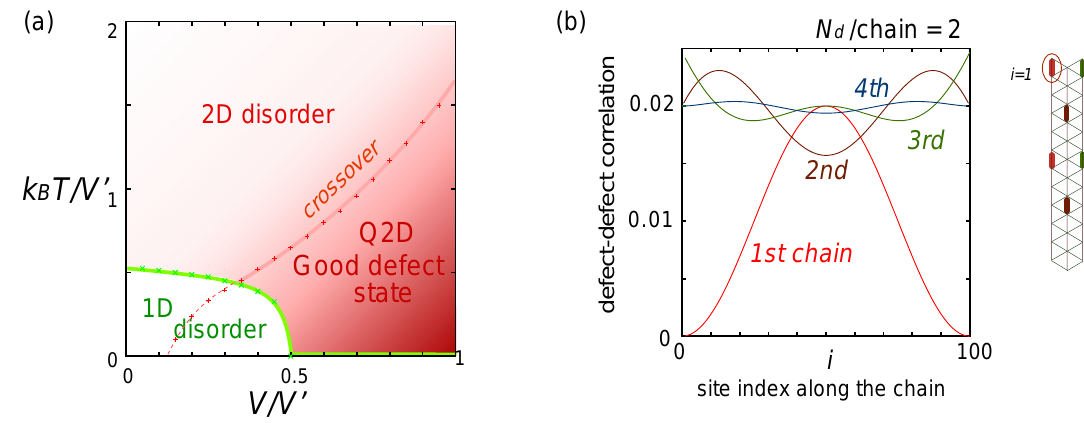
Figure 8. ( a ) Finite temperature phase diagram of the classical Ising model on an anisotropic triangular lattice at V (cid:48) > V [26] and ( b ) the defect-defect correlation function with one defect fixed to site i = 1 of the first chain